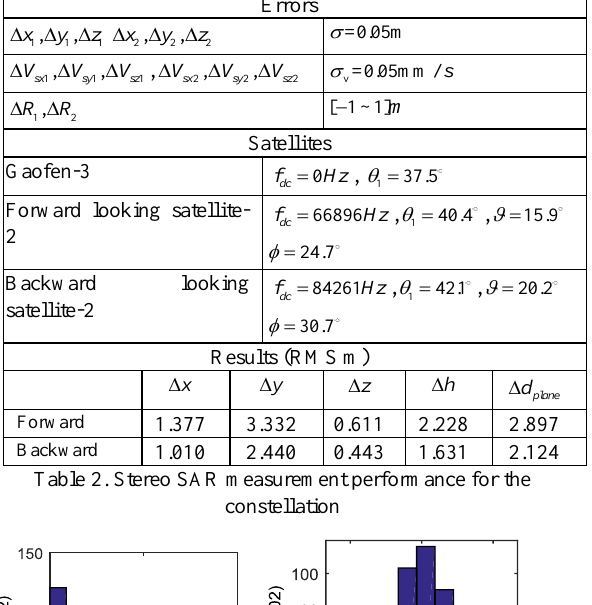
Figure 5. InSAR and DInSAR working mode illustration